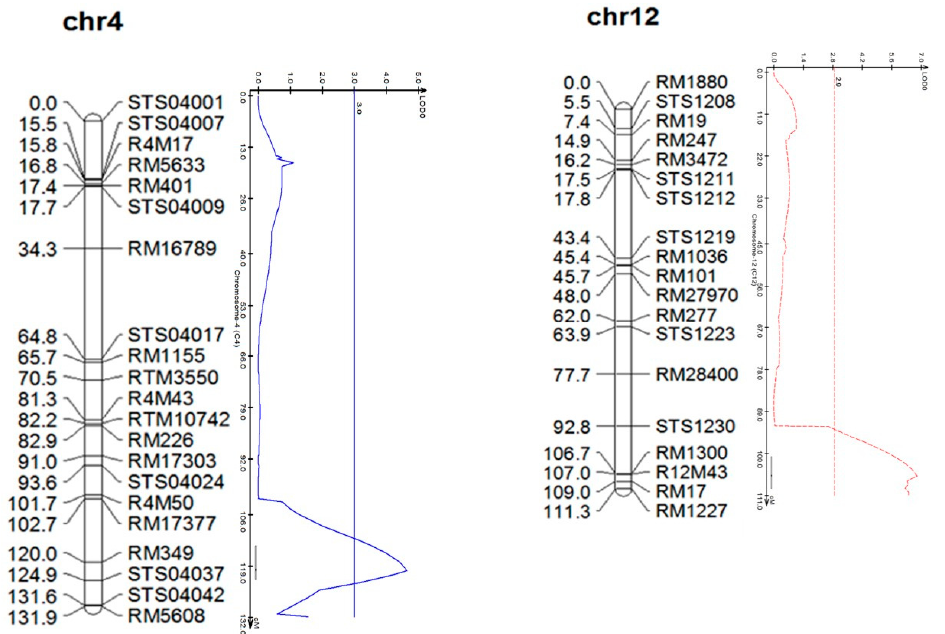
Figure 3. Genetic map showing the growth rate-related QTLs between two and four week-old seedlings of the MGRILs. qGA-4 in the blue peak indicates the green area; qPH-12 in the red peak indicates the plant height.